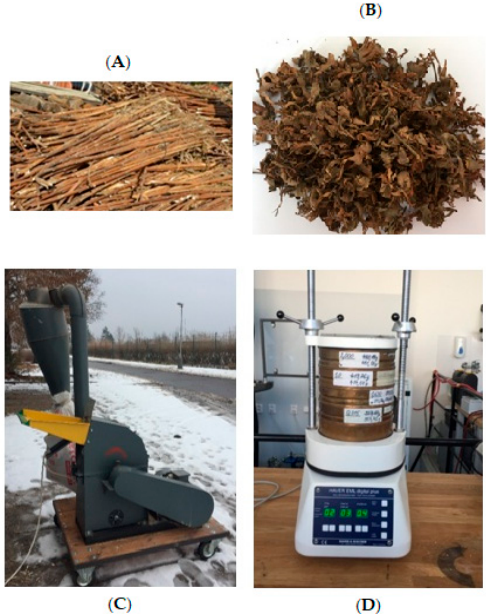
Figure 1. ( A ) Sunflower stalks and ( B ) hazelnut husks. ( C ) A 5.5 kW motor hammer mill (9FQ-40C, Pest Control Corporation, s.r.o., Vl č nov, Czech Republic) used to grind the biomass materials. ( D ) A sieve shaker (AS 200, Retsch, Haan, Germany) of four sieve opening sizes.